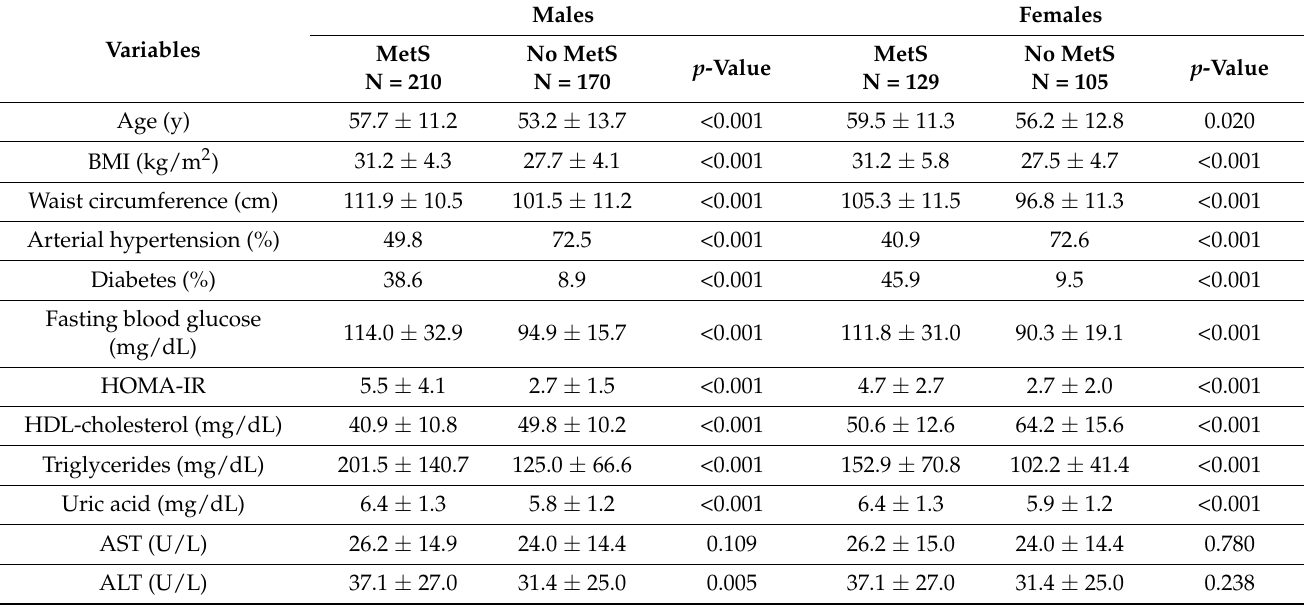
Table 1. Clinical and biochemical variables in males and females with and without metabolic syndrome (MetS).